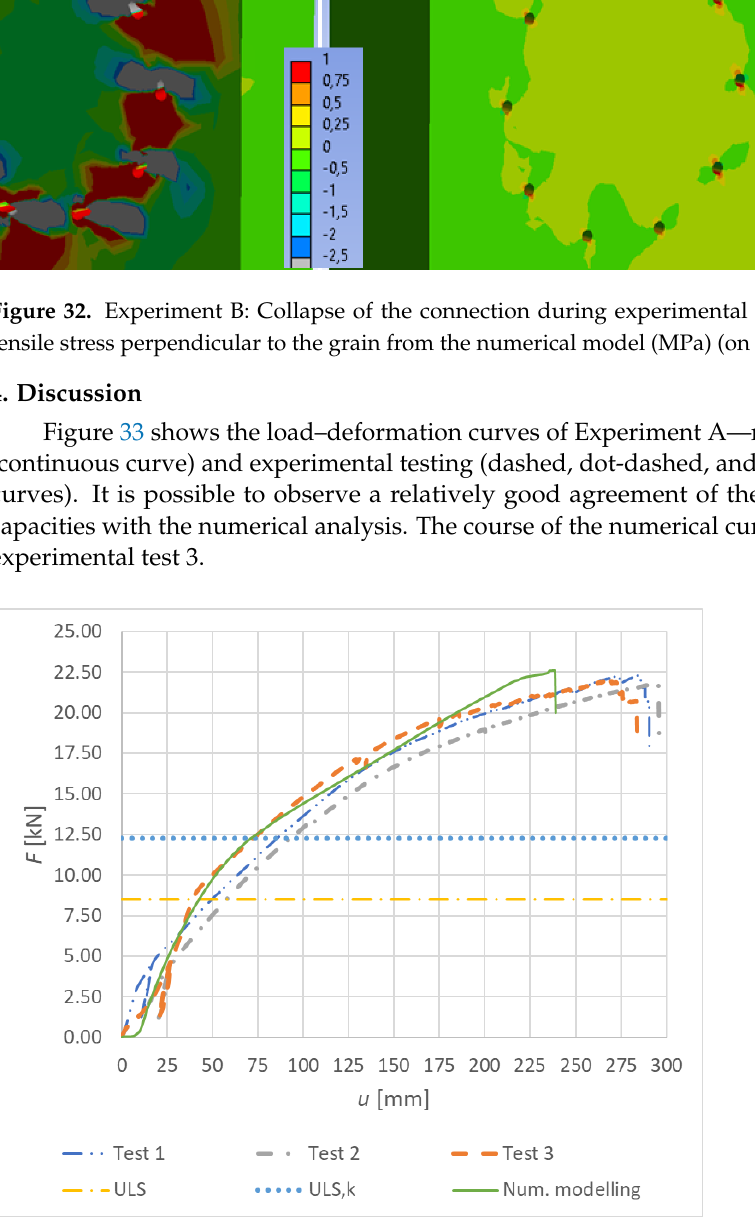
Figure 33. Load – deformation curves for Experiment A. Figure 33. Load–deformation curves for Experiment